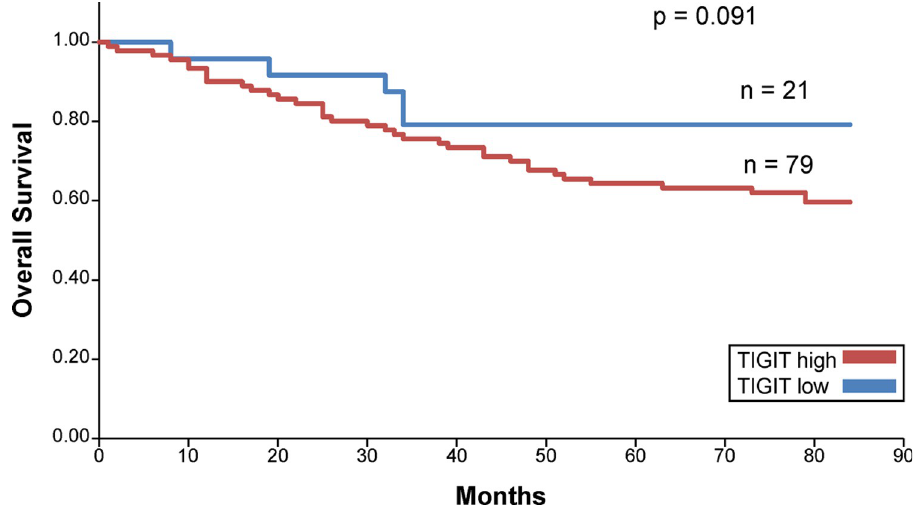
Fig 6. Overall survival curve for TIGIT.